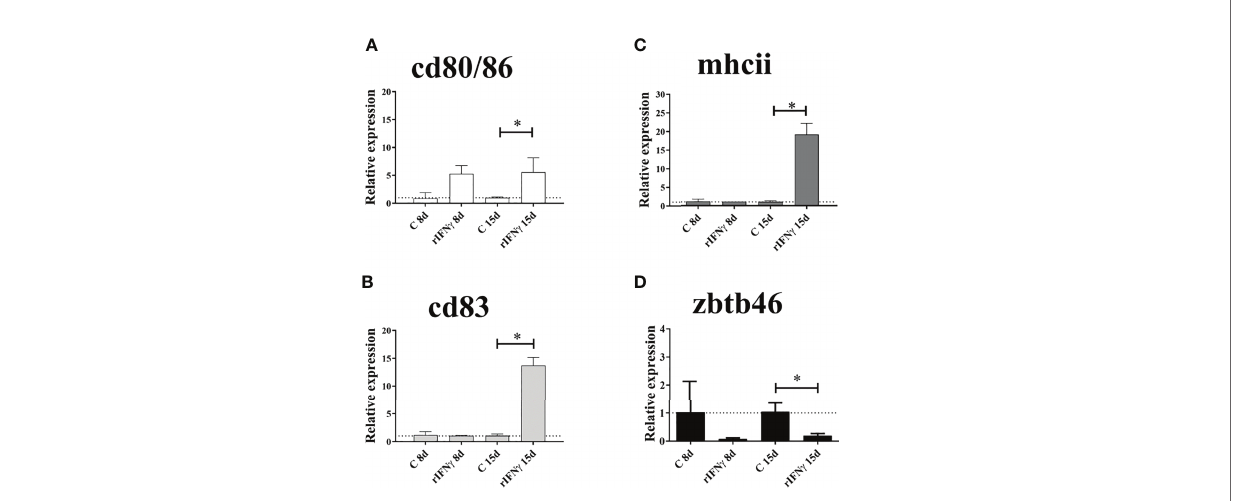
FIGURE 2 | Gene expression of cell-surface markers by RT-qPCR in splenocytes of Atlantic salmon cultured 8 and 15 days (with and without induction of IFN g ). (A) cd80/86 , (B) cd83 , (C) mhcii and (D) zbtb46 . The data were plotted in bars (n = splenocytes from four fi sh) showing the relative expression in fold change related to the control group. *: Signi fi cant difference ( P < 0.05) by Student ’ s t-test